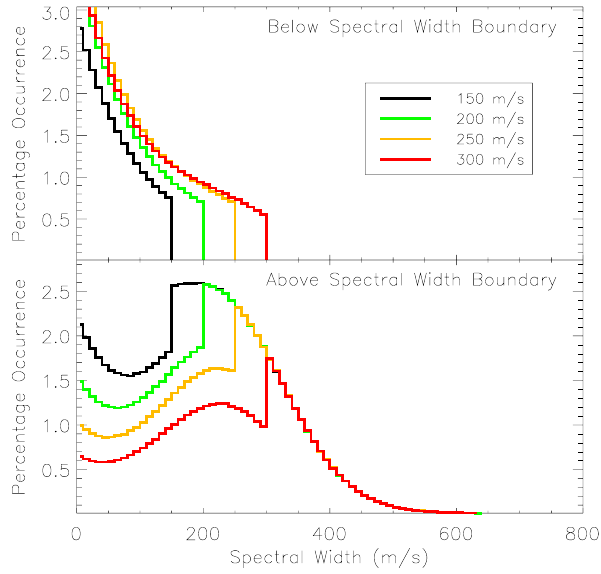
Fig. 3. The distribution of spectral width values below and above the spectral width boundary as determined theoretically for algo- rithm 1. The four different lines represent the results from using four different spectral width threshold values (150, 200, 250, and 300 m/s) to identify the